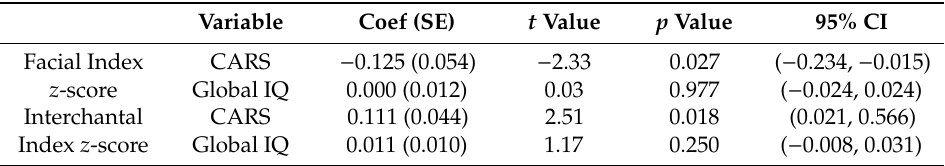
Table 4. Standard multiple regression analyses on facial Index and Interchantal Index z -scores, with Figure 3. Estimated Facial and Interchantal index z scores related to Cars score. CARS and Global IQ as dependent